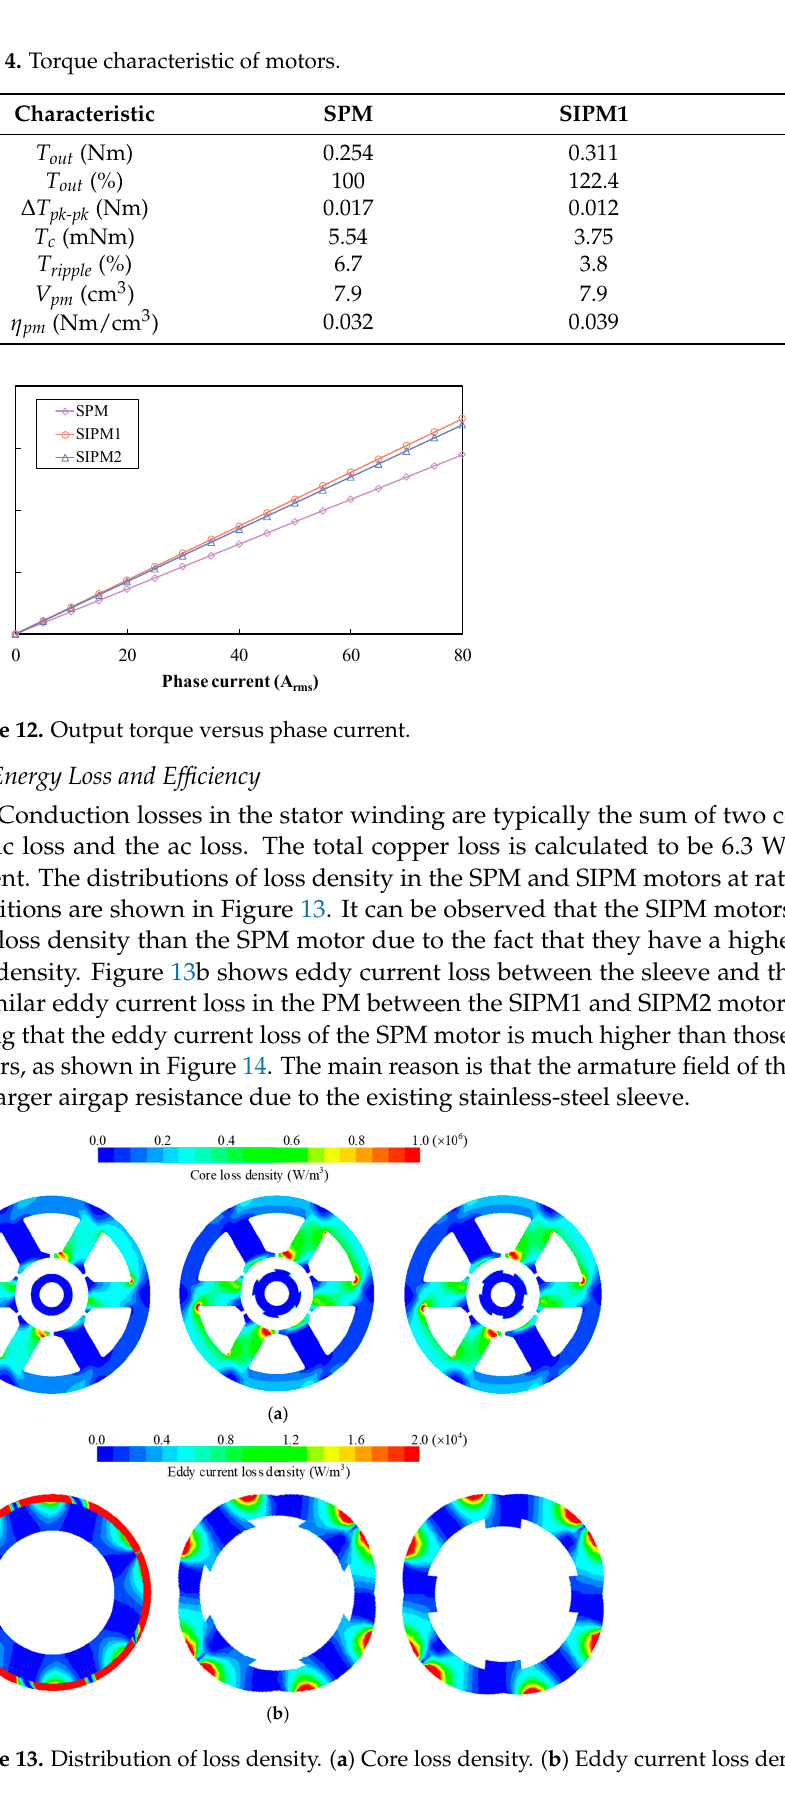
Figure 11. Output torque.